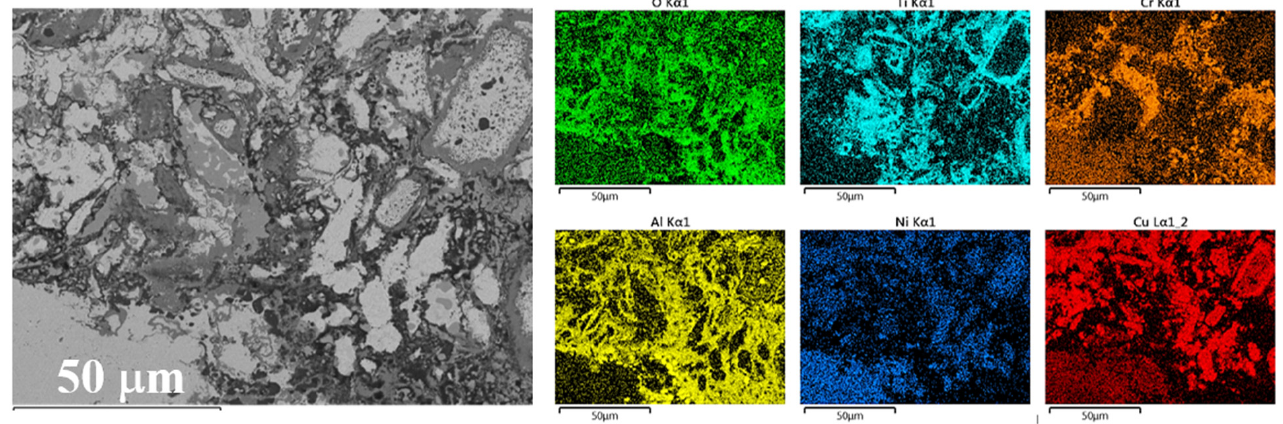
Figure 7. SEM micrograph and elemental mappings of the CrCuFeNiTiAl 0.05 sample.